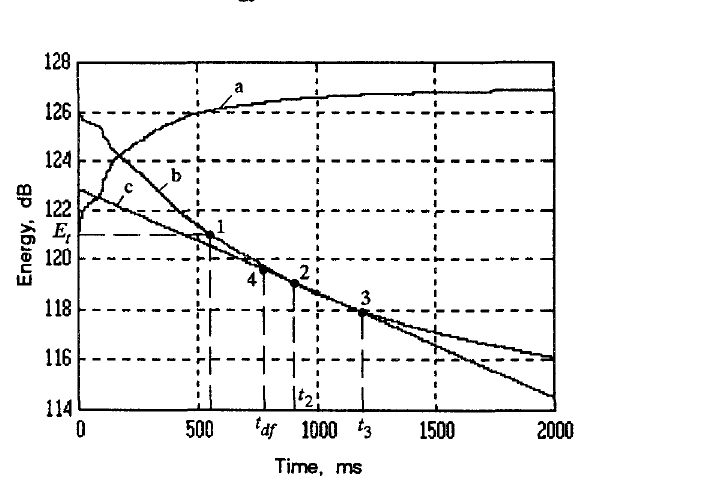
Fig 1. The growth and the attenuation of the sound field energy of a nonfiltered signal in relation to